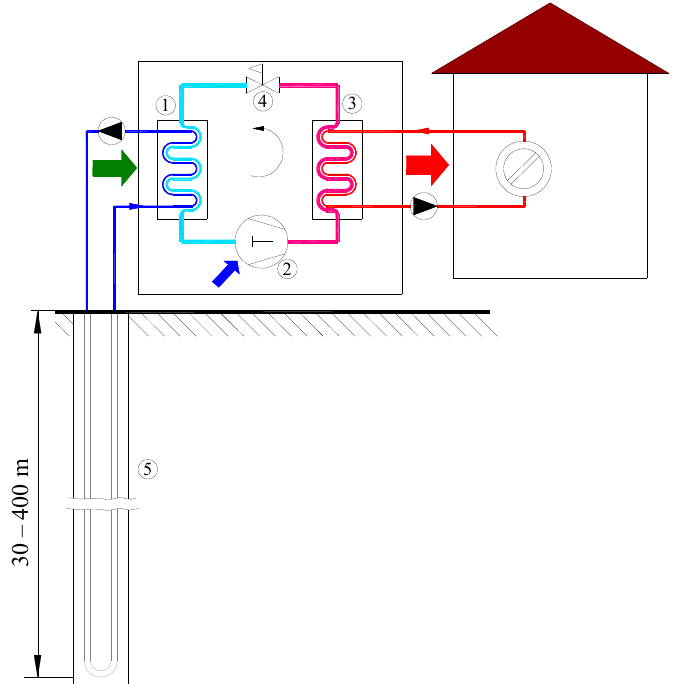
Figure 3. Vertical borehole heat exchanger coupled to the heat pump (1–evaporator, 2—compressor, 3—condenser, 4—expansion valve, 5—borehole heat exchanger).